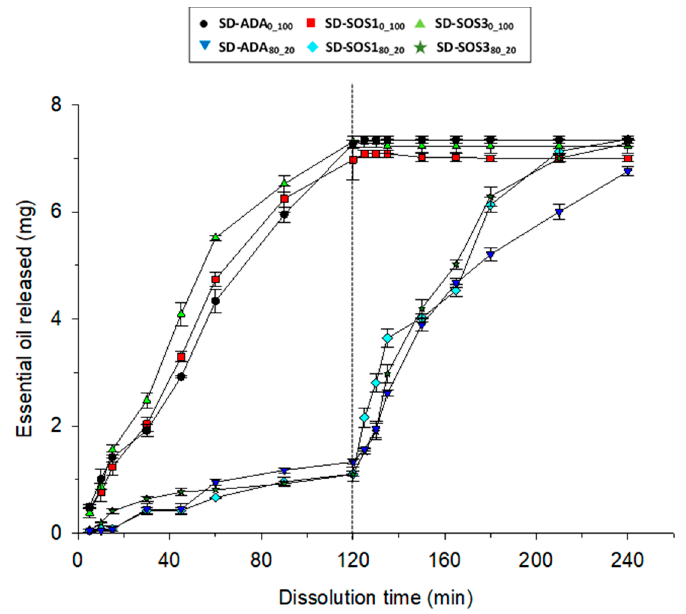
Figure 11. Release of oregano essential oil vs. time for the experimental spray-dried products (dotted line denotes pH change in the dissolution medium from 1.2 to 6.8).